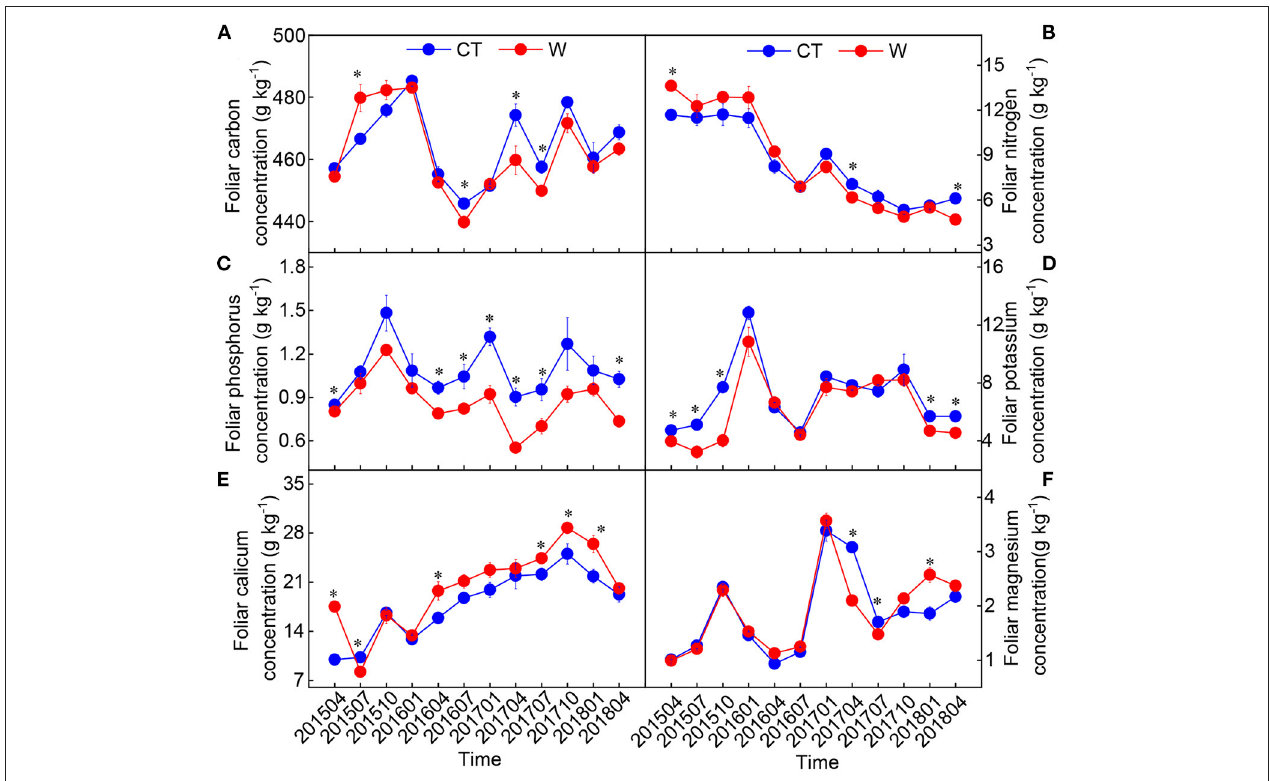
FIGURE 2 | Changes in foliar elements [ (A) carbon; (B) nitrogen; (C) phosphorus; (D) potassium; (E) calicum; (F) magnesium] in Cunninghamia lanceolata between warming (W) and control (CT) (mean ± standard error, n = 5). *Above the dot indicates a significant difference between warming and control treatments at the level of p < 0.05.